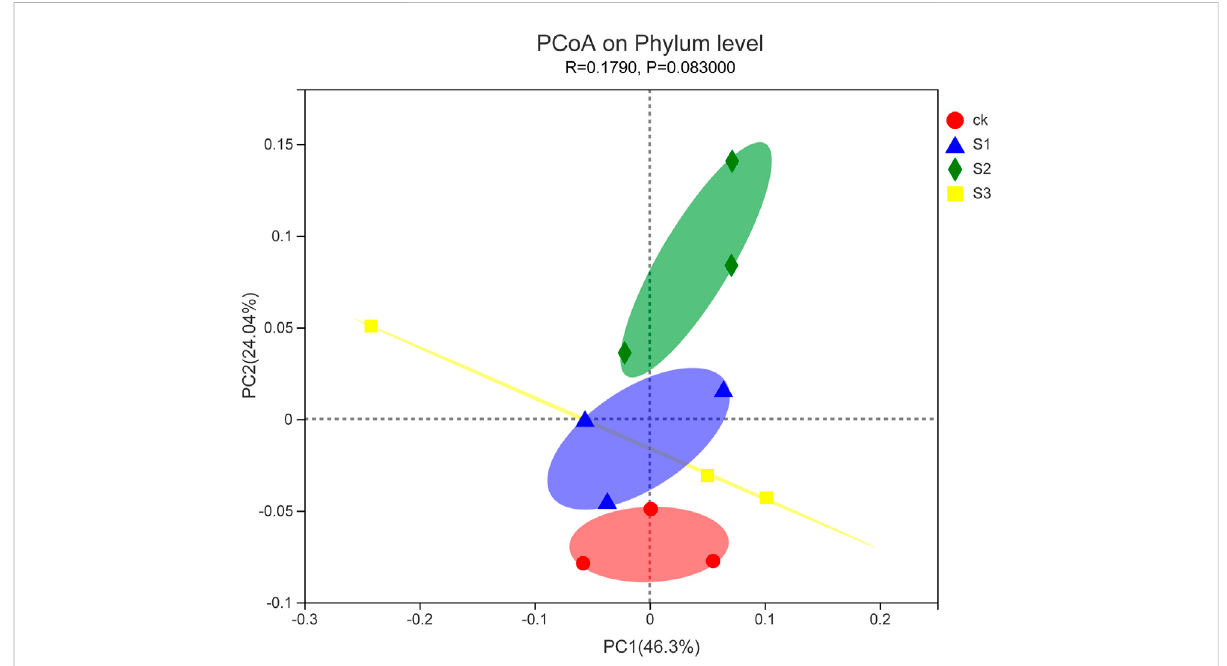
FIGURE 6 PCoA plot of the relationship between samples based on similarity in the community composition of bacterial OTUs. Two fi rst components (PCoA 1 and PCoA 2) were plotted and represent 70.34% of the variation.